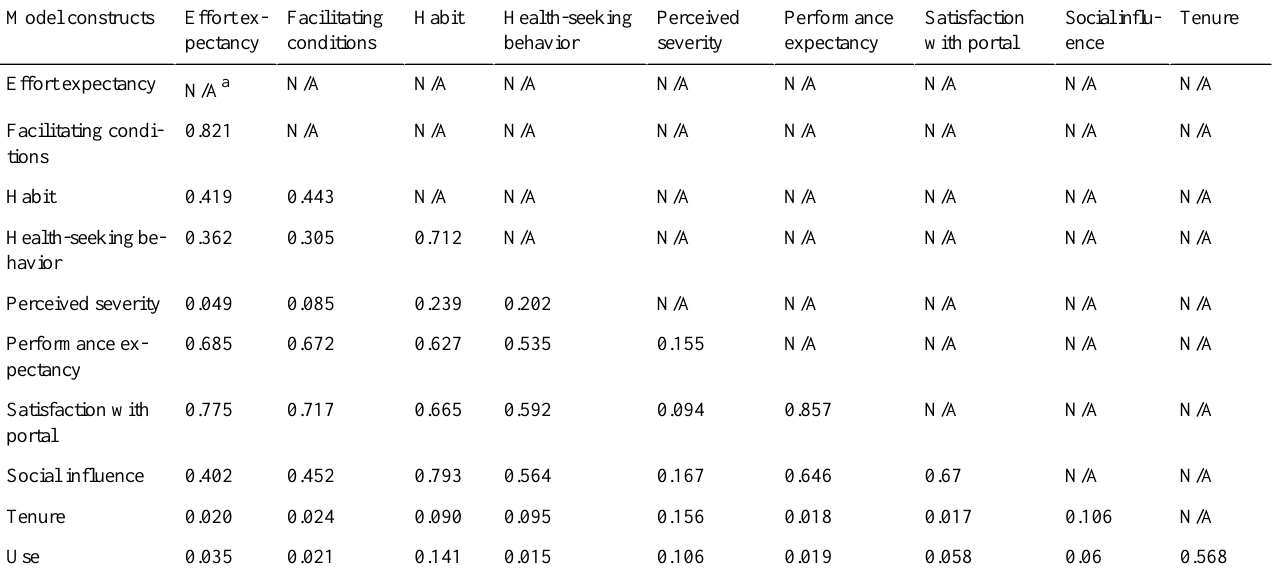
Table 4. Discriminant